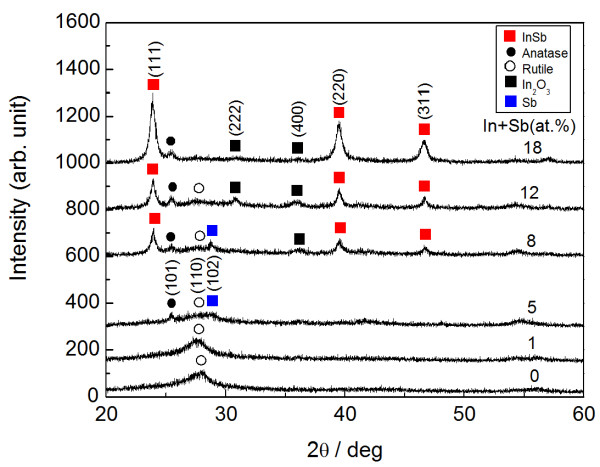
XRD pattern for InSb-added TiO2 thin films with different In + Sb concentrations. Red squares indicate InSb, black squares indicate In2O3, blue squares indicate Sb, dots indicate TiO2 with anatase structure, and circles indicate TiO2 with rutile structure.